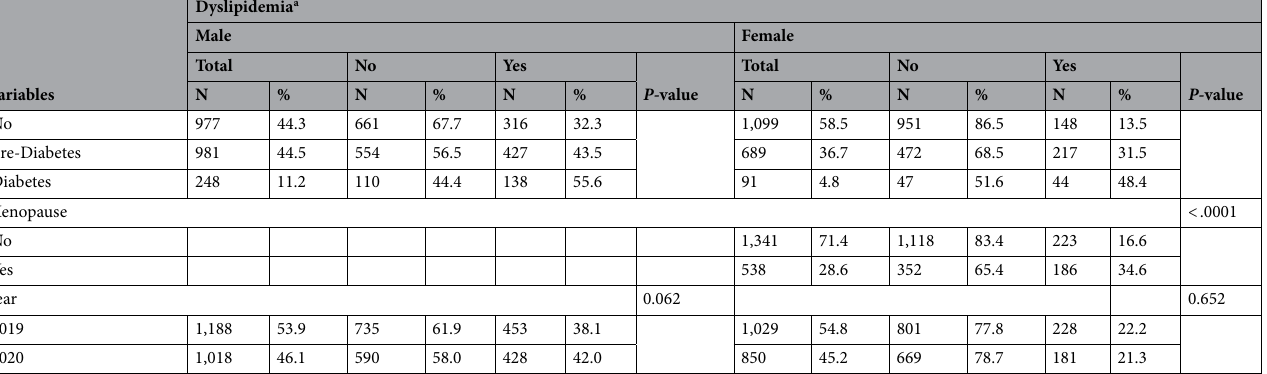
Table 1. General characteristics of the study population. BMI body mass index. a One of the